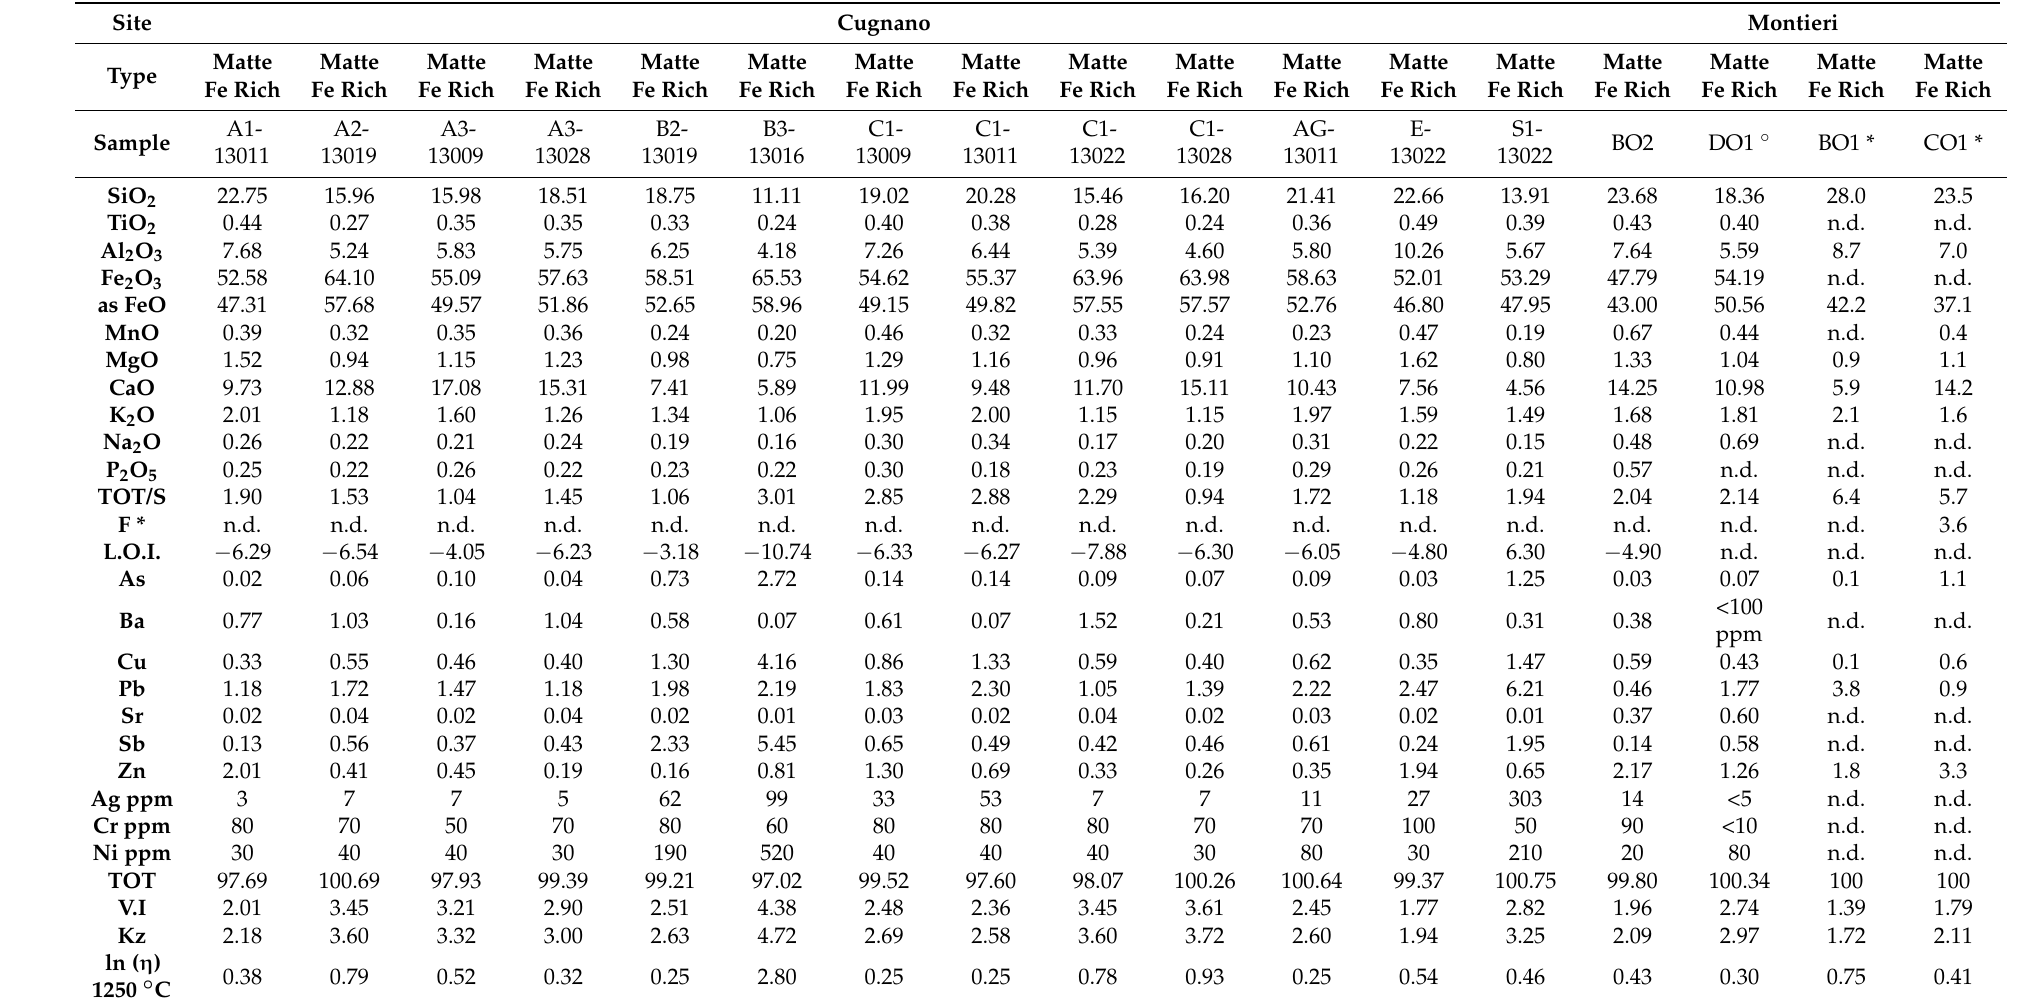
Table 2. Chemical composition of Matte Fe-rich